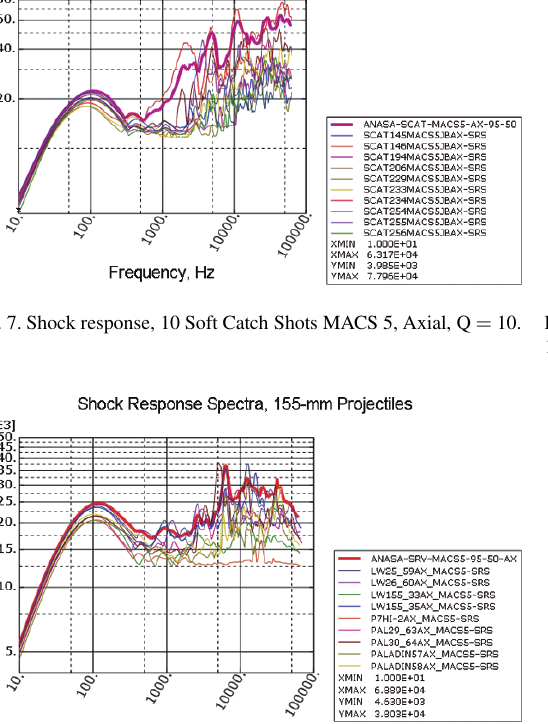
Fig. 9. Shock response spectrum for 9 near-tactical shots, axial, Q = 10.